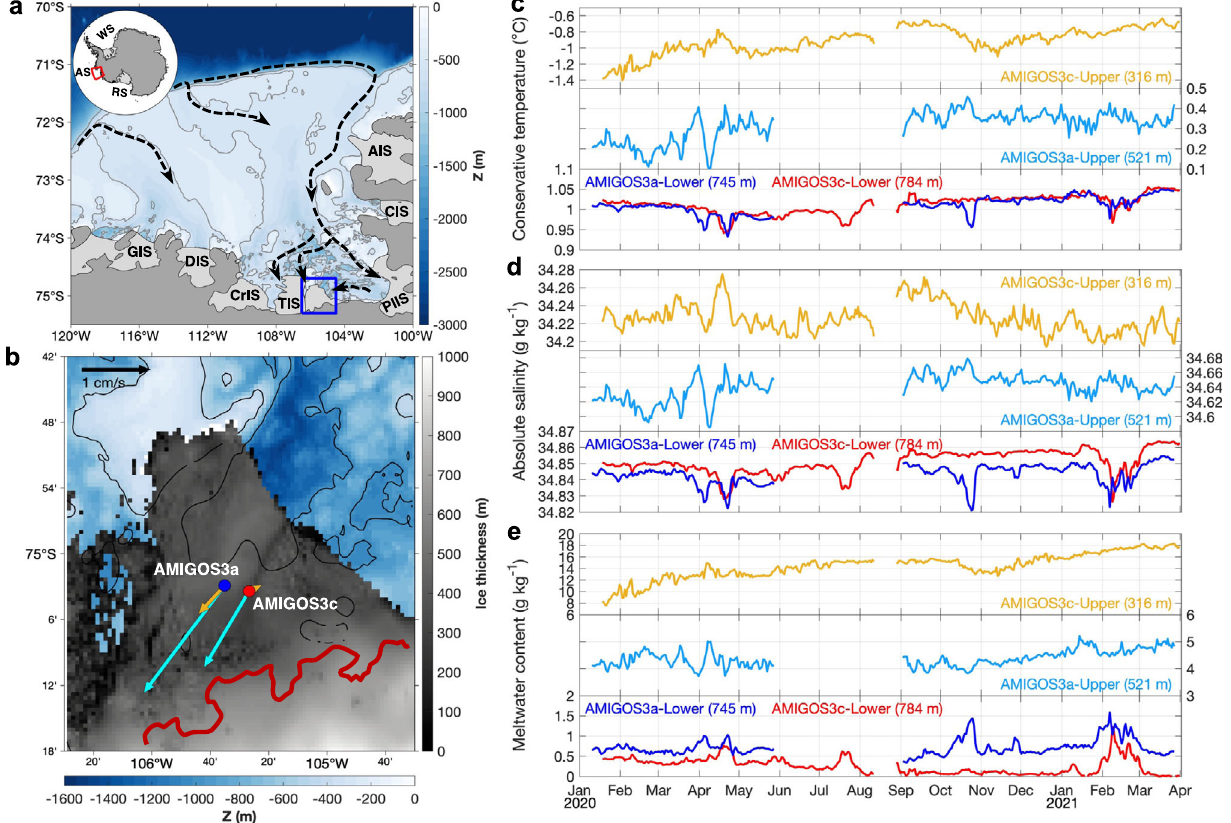
Fig. 1 | Study region and hydrographic properties variability. a Bathymetry of the continental shelf of the Amundsen Sea showing a schematic of the main pathways of modi fi ed Circumpolar Deep Water (mCDW; back dashed arrows) and ice shelves: Abbot Ice Shelf (AIS), Cosgrove Ice Shelf (CIS), Pine Island Ice Shelf (PIIS),ThwaitesIceShelf(TIS),CrossonIceShelf(CrIS),DotsonIceShelf(DIS),and Getz Ice Shelf (GIS). Thwaites Eastern Ice Shelf (TEIS) is delimited by the blue rectangle. b TEIS study region showing the AMIGOS3a (blue dot) and AMIGOS3c